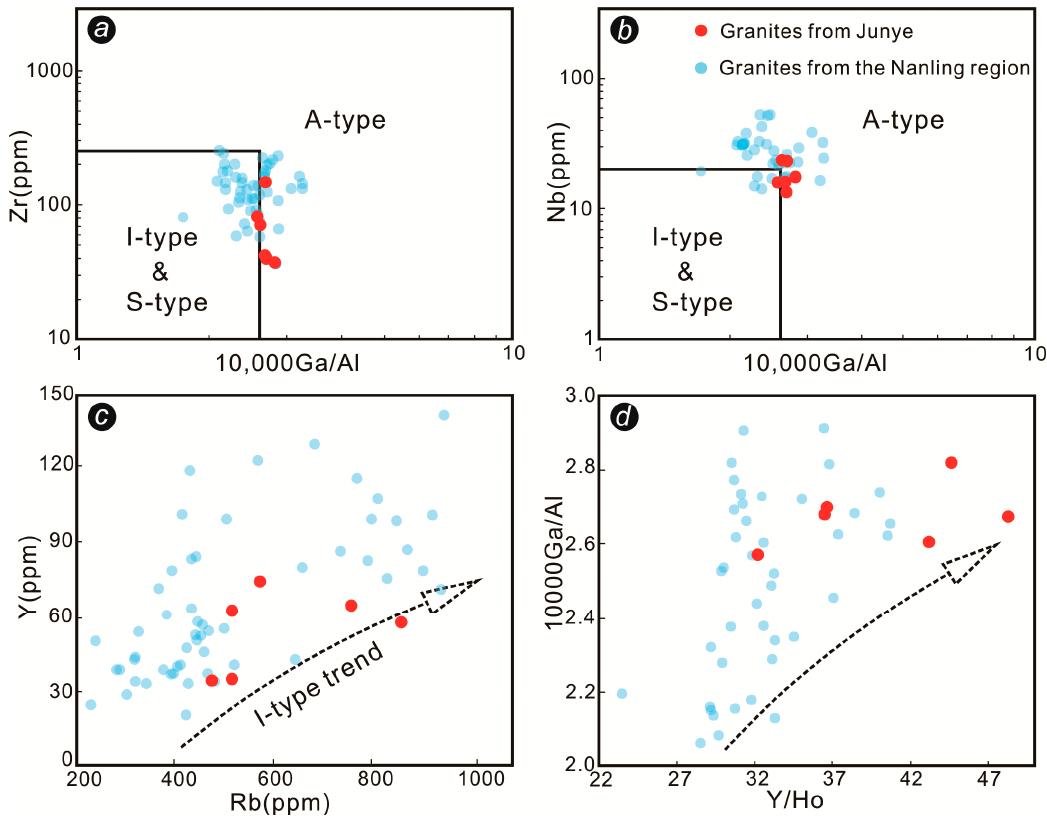
Figure 7. Discrimination diagrams relevant to the genetic type of granites: ( a ) and ( b ) plots of Zr vs. 10,000Ga/Al and Nb vs. 10,000Ga/Al (fields after Whalen et al. [65]); ( c ) and ( d ) plots of Y vs. Rb and 10,000Ga/Al vs. Y/Ho. The compositions of trace elements for granites in the Nanling area are cited from Zhang et al. [35], Huang et al. [23], Yu et al. [38], Zhou et al. [16], Liu et al. [43] and Gu et al. [25].